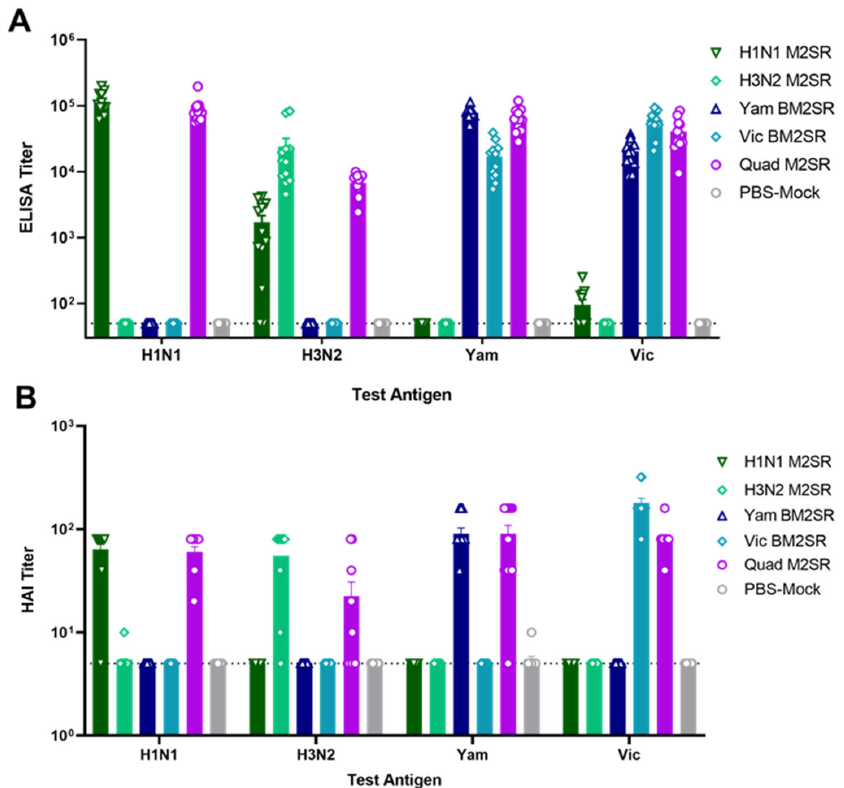
Figure 6. Serum antibody responses in ferrets following M2SR vaccination. Serum samples were collected from immunized ferrets 1 week following boost inoculation. ELISA titers ( A ) against analogous H1N1, H3N2, B/Yam, and B/Vic HA antigens were determined. HAI titers ( B ) against these viruses were determined for RDE-treated sera. Open faced symbols (e.g., triangles, diamonds, circles, etc.) represent titers from individual mice within the group, while colored bars represent the mean titer for the indicated group.The ELISA and HAI detection limits were 50 and 5, respectively, and indicated by a dashed line.